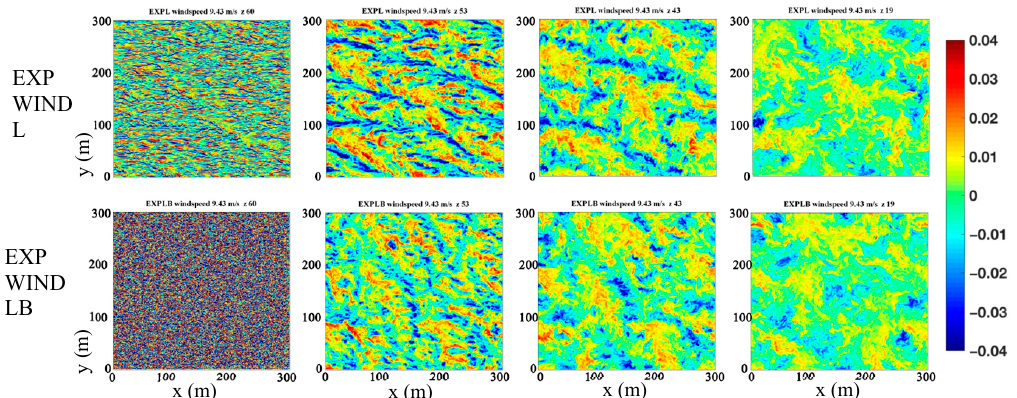
Figure 4. Horizontal cross-section of vertical velocity (m/s) (z =1, 8, 18, and42 m) for EXP WIND L and EXP WIND LB. Table 2. Values of wind stress ( τ , N/m 2 ) and turbulent Langmuir number (La t ) for different wind speeds (U, m/s).